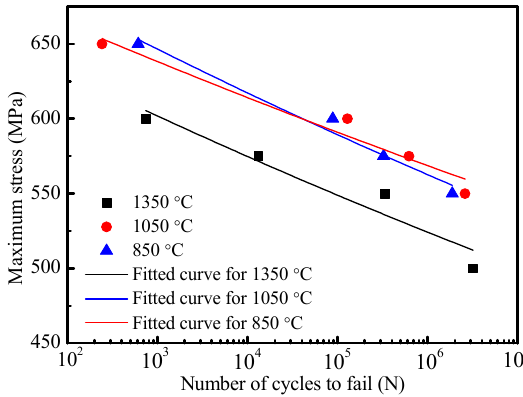
Figure 5. Fatigue life at different peak temperatures.